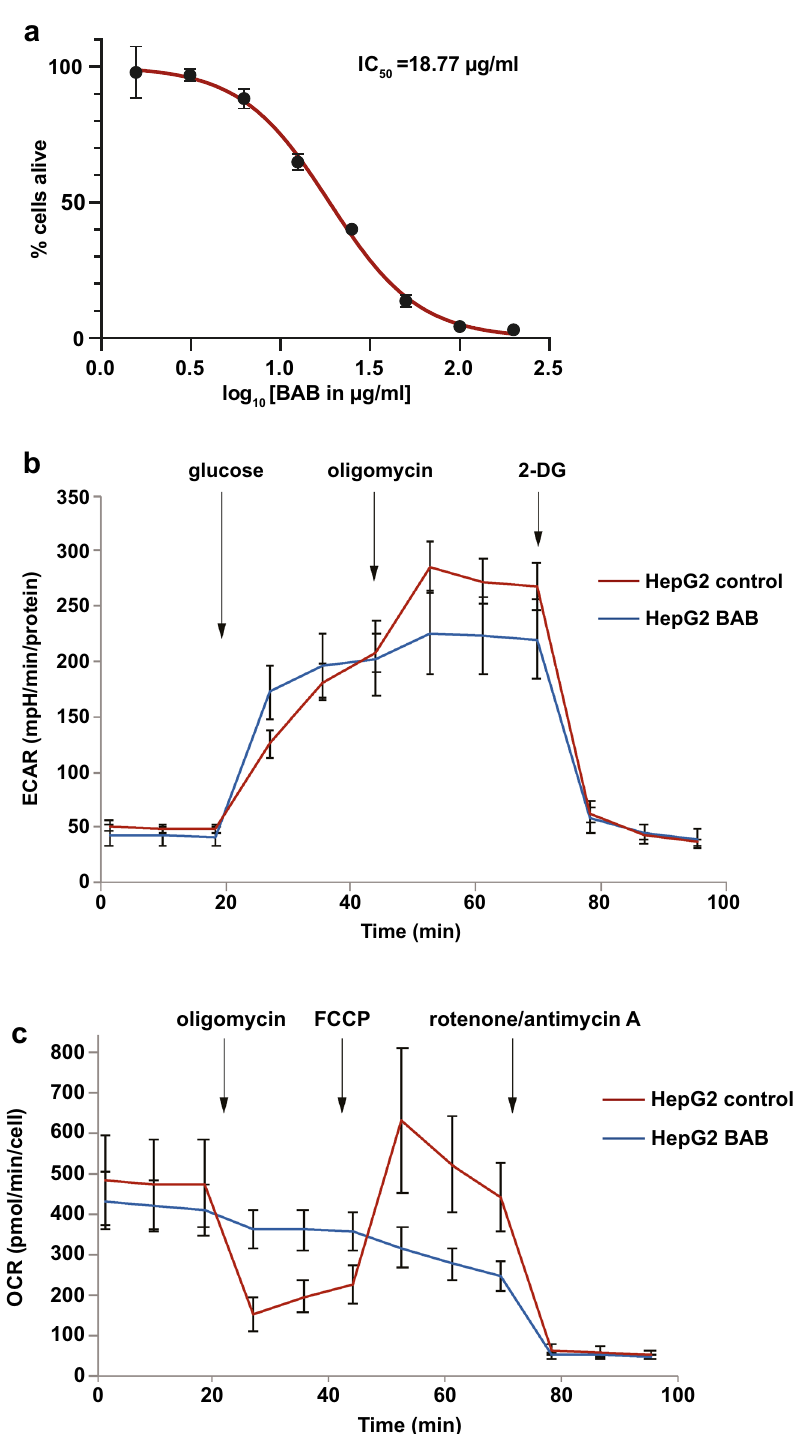
Figure 6. Cytotoxicity of BAB on HepG2 cells may be caused by effects on energy metabolism. ( a ) HepG2 cells with BAB in different concentrations were incubated for 20 h and afterwards resazurin was added. The ability to reduce blue resazurin to red resorufin was measured at 540 nm. The average intensity of DMSO control was set as 100% alive and the percentage of intensity from each treated sample was calculated. The mean from biological triplicates was plotted with error bars representing the SEM in black. Nonlinear regression was analyzed and plotted in red, on which IC 50 was based. ( b , c ) HepG2 cells either untreated or pre-treated with BAB were compared in a glycolysis and mitochondrial test using Seahorse technology to measure extracellular acidification rates (ECAR) in mpH/minute and oxygen consumption rates (OCR) in pmol O 2 / minute. ( b ) For the glycolysis stress test, 10 mM glucose, 5 μM oligomycin and 100 mM 2-deoxyglucose (2-DG) were injected into each well after 18, 36 and 65 min respectively. ( c ) For the mitochondrial stress test, 5 μM oligomycin, 2 μM FCCP and 1 μM of Rotenone and Antimycin A were injected to each well after 18, 45 and 63 min respectively. Both ECAR and OCR were normalized to individual protein amount, and data from biological triplicates were presented by mean with error bars representing the